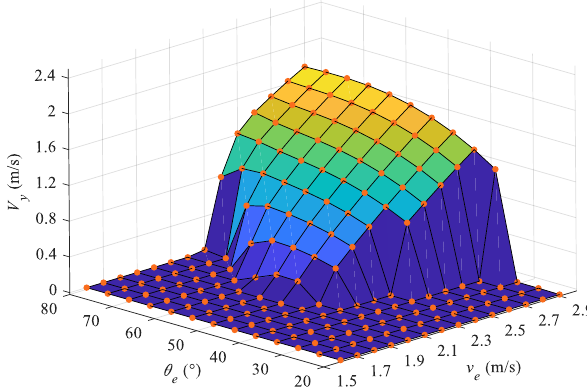
Figure 12. Velocities at the end of the water-exiting